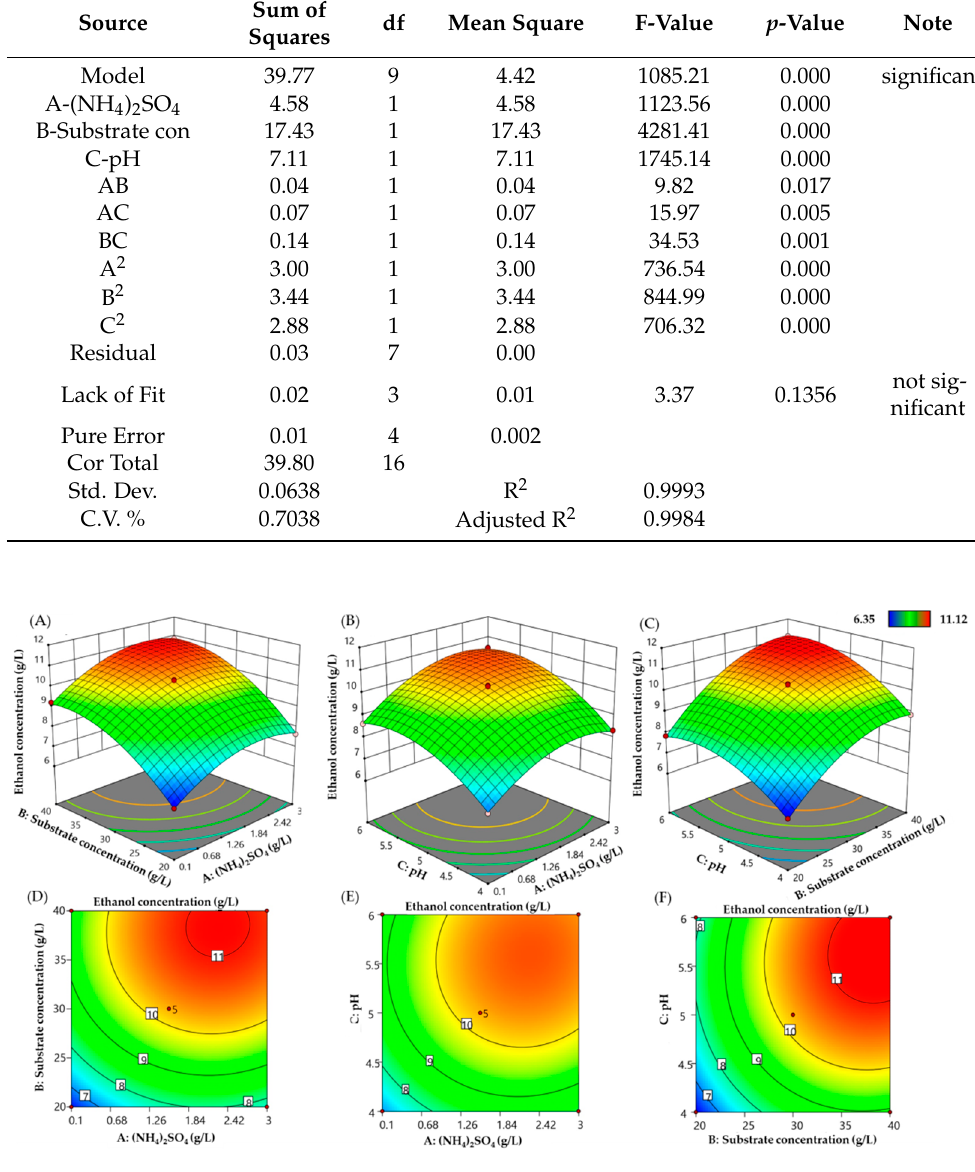
Figure 4. Response surface plot and related contour plot displaying the simultaneous effects of (NH 4 ) 2 SO 4 andsubstrate concentration ( A and D ); (NH 4 ) 2 SO 4 and initial pH ( B and E ); substrate con- centration and initial pH ( C and F ) on ethanol production.